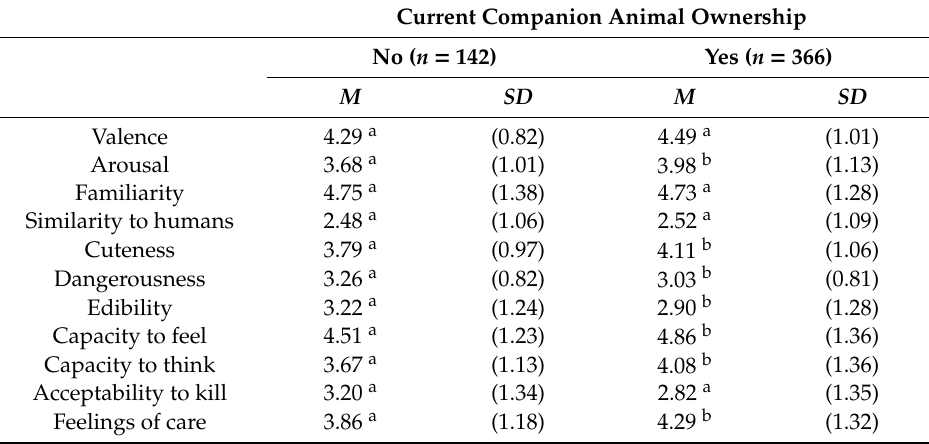
Table 5. Mean scores for evaluative dimensions by current companion animal